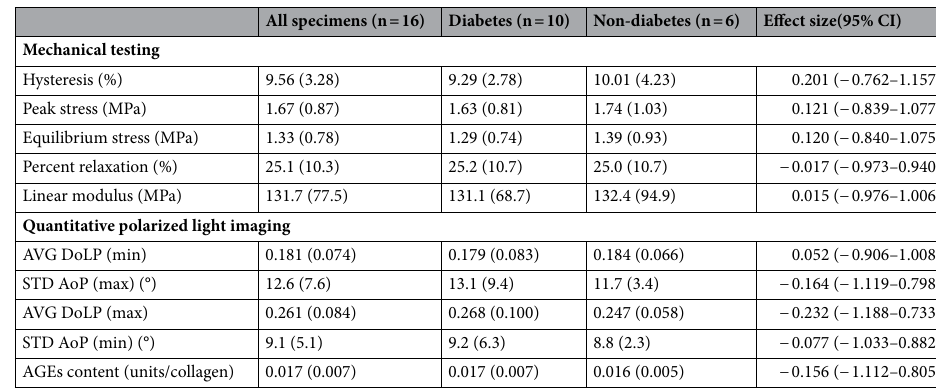
Table 2. Descriptive statistics for mechanical testing, collagen alignment, and advanced glycation end- products (AGEs) content. Values for diabetes and non-diabetes specimens are Mean(SD); average degree of linear polarization (AVG DoLP), standard deviation angle of polarization (STD AoP), minimum (min), maximum